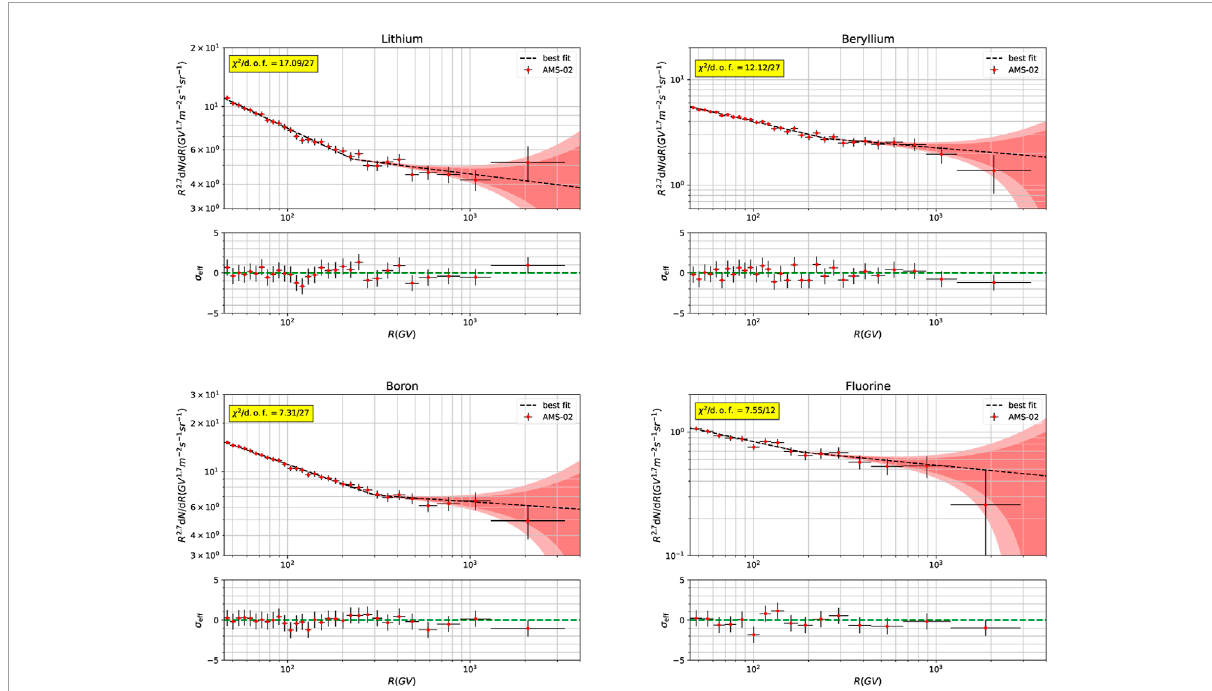
FIGURE 2 Fitting results and corresponding residuals to the secondary CR nuclei spectra (Li, Be, B, and F). The 2 σ (deep red) and 3 σ (light red) bounds are also shown in the subfigures. The relevant reduced χ 2 value of each spectrum is given in the subfigures as well.